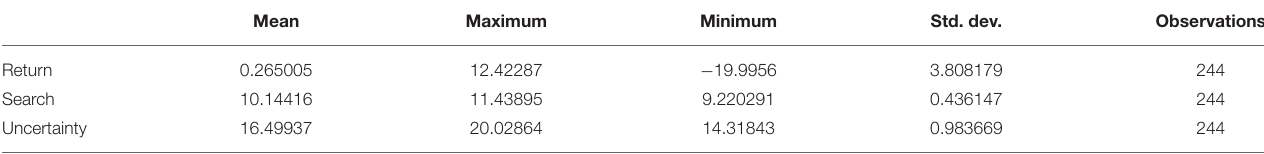
TABLE 1 | Statistical description of the main variables.